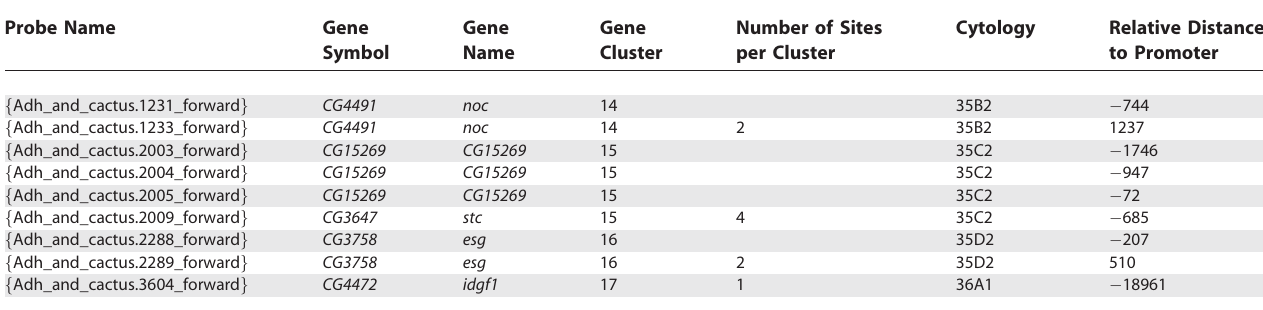
This table lists the PRC1 binding sites on the X chromosome and Chromosome 2L at the embryonic stage. The first column indicates the name of the feature on MY arrays. The name contains the absolute coordinate of the 5 9 end of the fragment along the chromosome (with the exception of part of the ph locus, see below). Adjacent fragments are thus generally spaced by 1.8 kb to 2 kb for the X chromosome and by less than 1 kb on Chromosome 2L. Sequences corresponding to these features can be found in Tables S6–S8. The two following columns list the genes with the closest promoters to the selected binding site. Genes are named based on their CG symbol (column 2) and their name symbol (column 3). Column 4 indicates the different gene clusters with PRC1 binding sites and column 5 shows the number of binding sites for each cluster. Column 6 indicates the cytology of the target genes on polytene chromosomes, and column 7 indicates the relative distance of each binding site to the closest gene promoter. (cid:3) is upstream and þ is downstream to the promoter. Note that in column 7 no relative distance can be calculated in two cases. The cells containing the letter A correspond to the ph gene region. This gene is duplicated and the release 4 of the genome misses those sequences. We designed MY arrays in this region based on the sequence entry M64750. In the case of